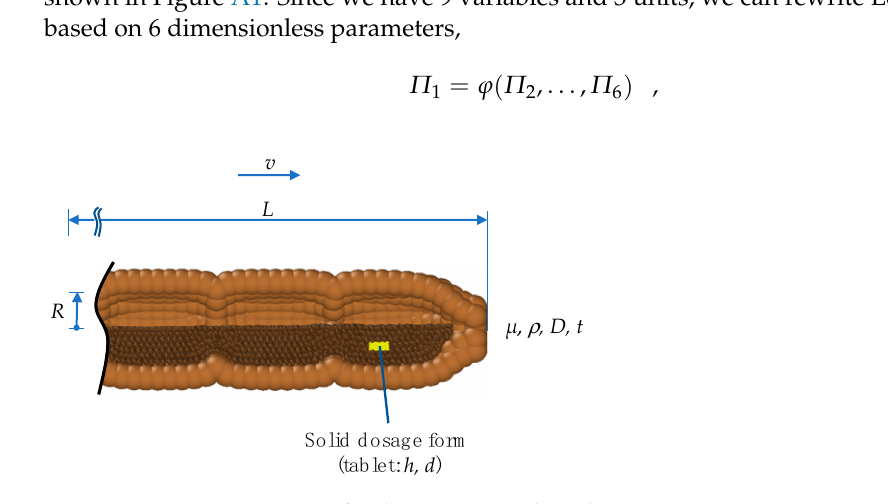
Figure A1. System parameter for the Dimensional Analysis. Table A1. Variables for the Dimensional